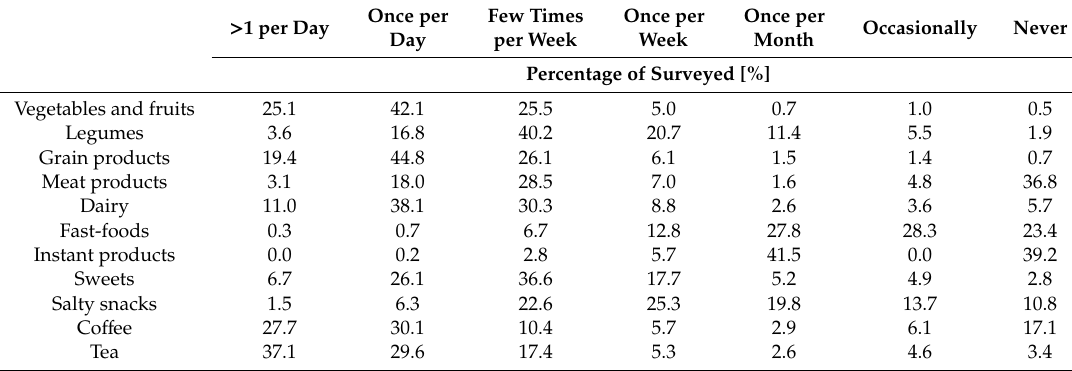
Table 3. The frequency of consumption of particular foods during quarantine in Poland in the surveyed group ( n = 1097). Few Times Once per Once per > 1 per Day Once per Occasionally Never Day per Week Week Month Percentage of Surveyed